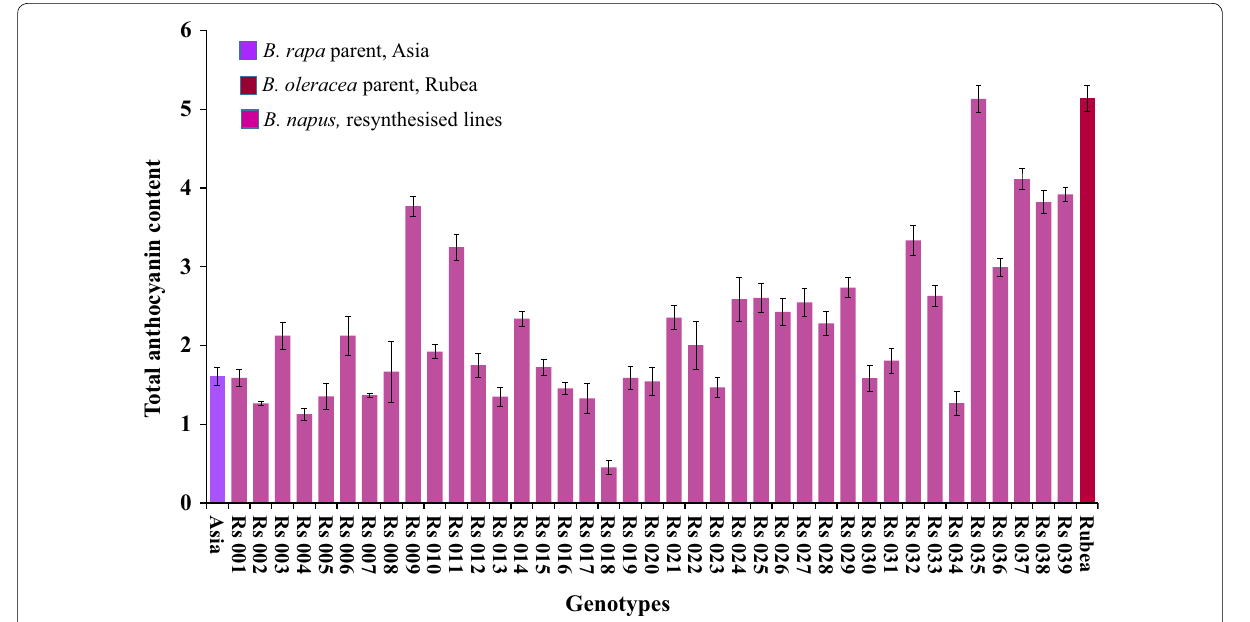
Fig. 2 Total anthocyanin contents in 39 resynthesized B. napus lines along with their parental lines